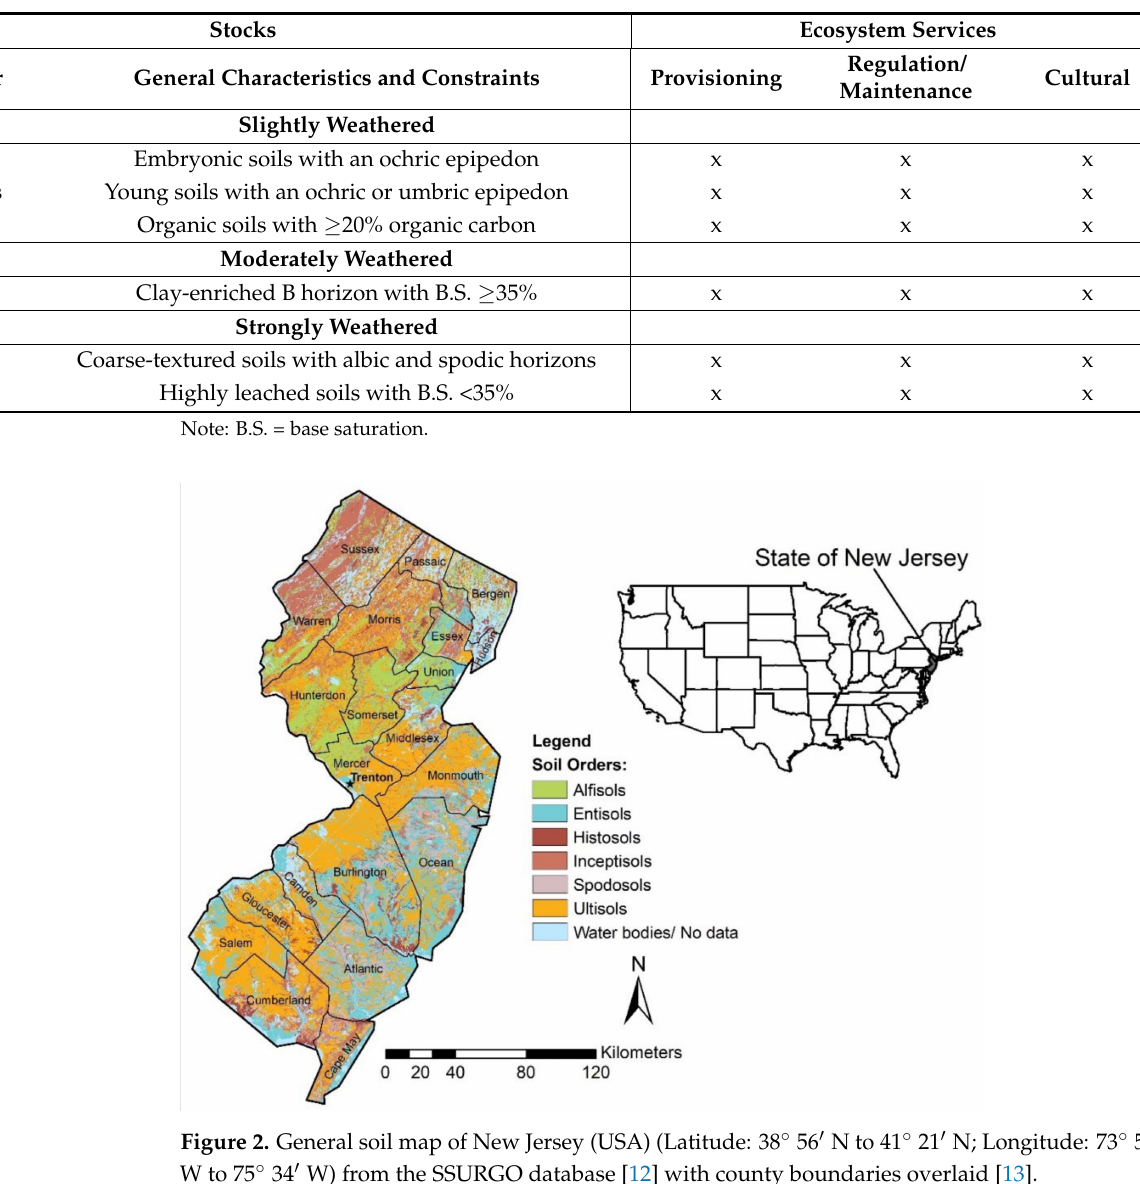
Table 1. Soil diversity (pedodiversity) is represented by taxonomic diversity at the soil order level with ecosystem service types in New Jersey (USA) [11].